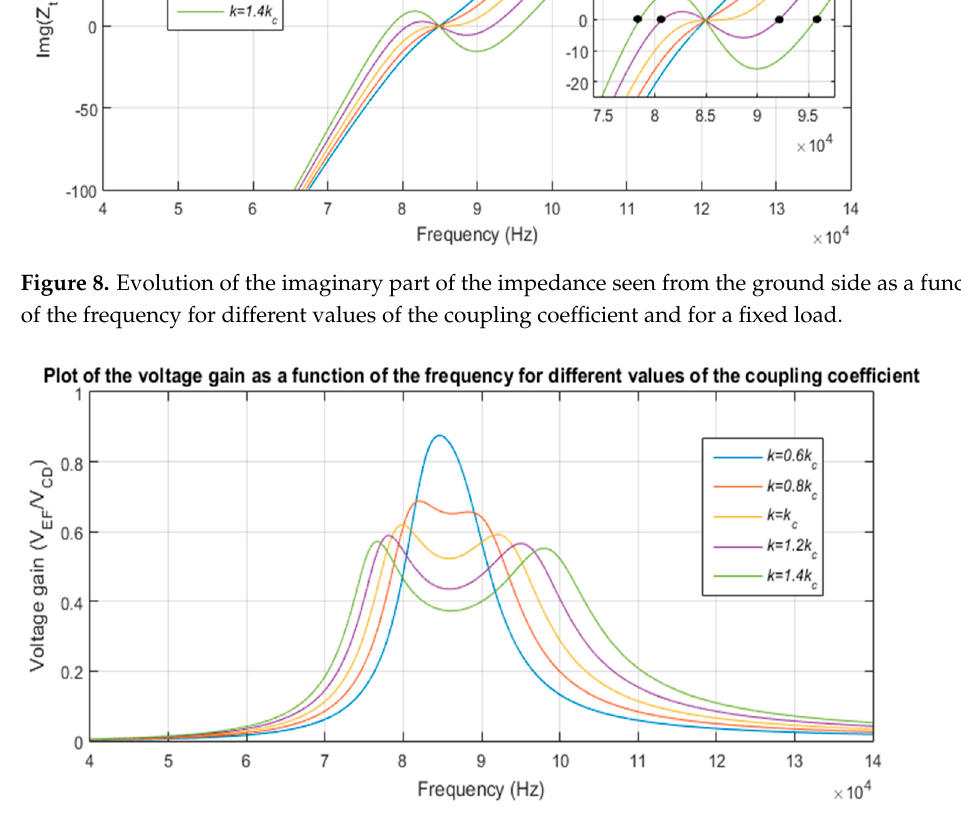
Figure 8. Evolution of the imaginary part of the impedance seen from the ground side as a function of the frequency for different values of the coupling coefficient and for a fixed load .